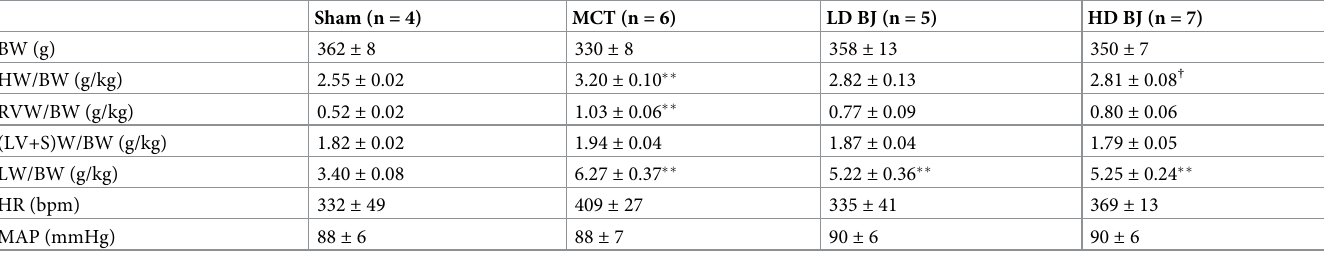
Table 1. Effects of nitrate-rich BJ supplementation on various parameters.